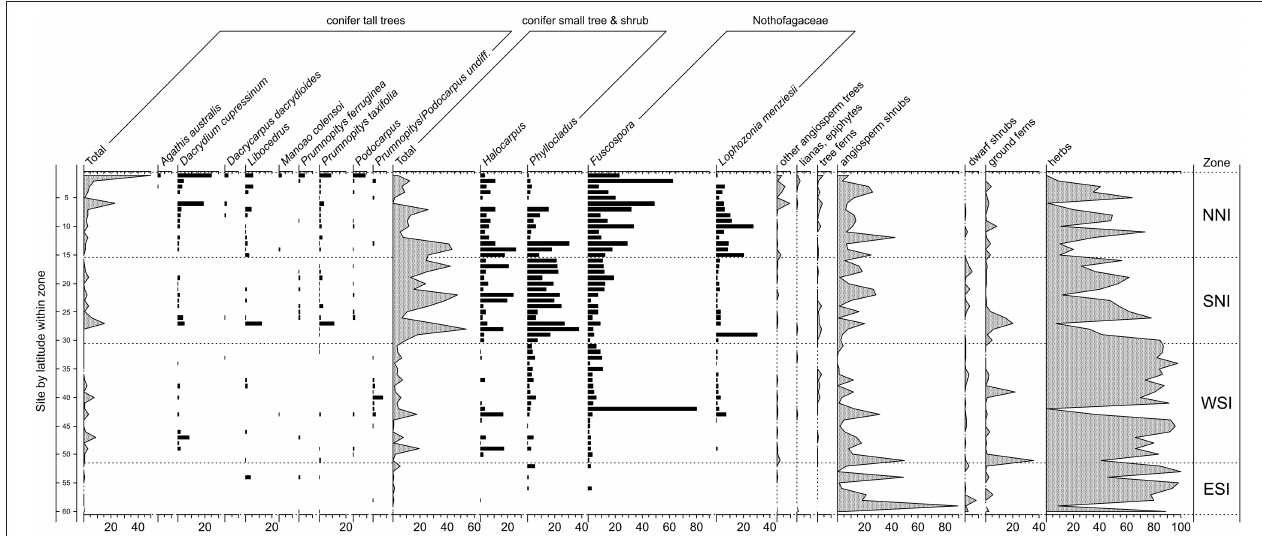
FIGURE 3 | Pollen and spore results for representative samples within sites dating to the LGM. In descending order of increasing latitude within broad zones: northern North Island (NNI–north of latitude 37 ◦ S); southern North Island (SNI–south of 37 ◦ S but including the overlapping portion of the South Island); western South Island (WSI–west of the Southern Alps); eastern South Island (ESI–east of the Southern Alps). Pollen sum: all terrestrial types excluding ferns, lycopods, and wetland forbs, rushes, and sedges. After McGlone et al.